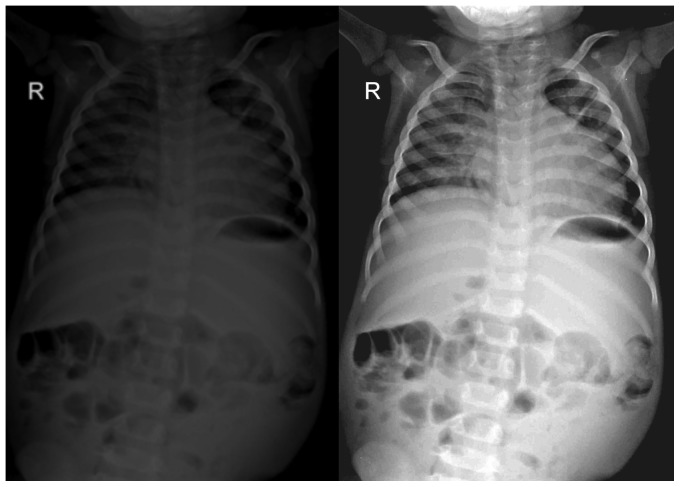
Post processing functions with Digital X- Rays.Note: This is an example of how the quality of digital X-rays could be enhanced by image processing. Depicted on the left is the original X-ray, on the right the same X-ray after digital image manipulation.